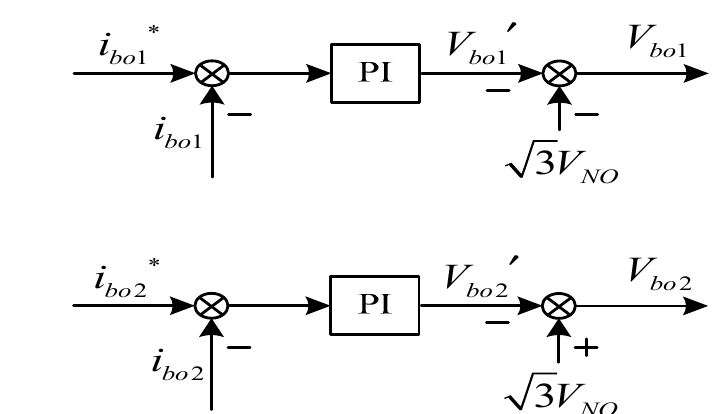
Figure 5. Control loop of PI controller for system 2.